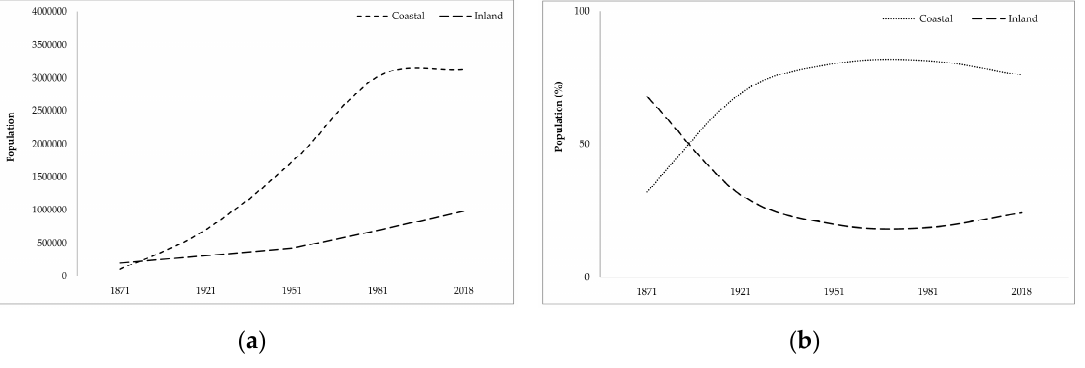
Figure 3. Total resident population ( left ) and percent share of the resident population ( right ) in the total population by district in Rome's metropolitan area, 1871–2018.